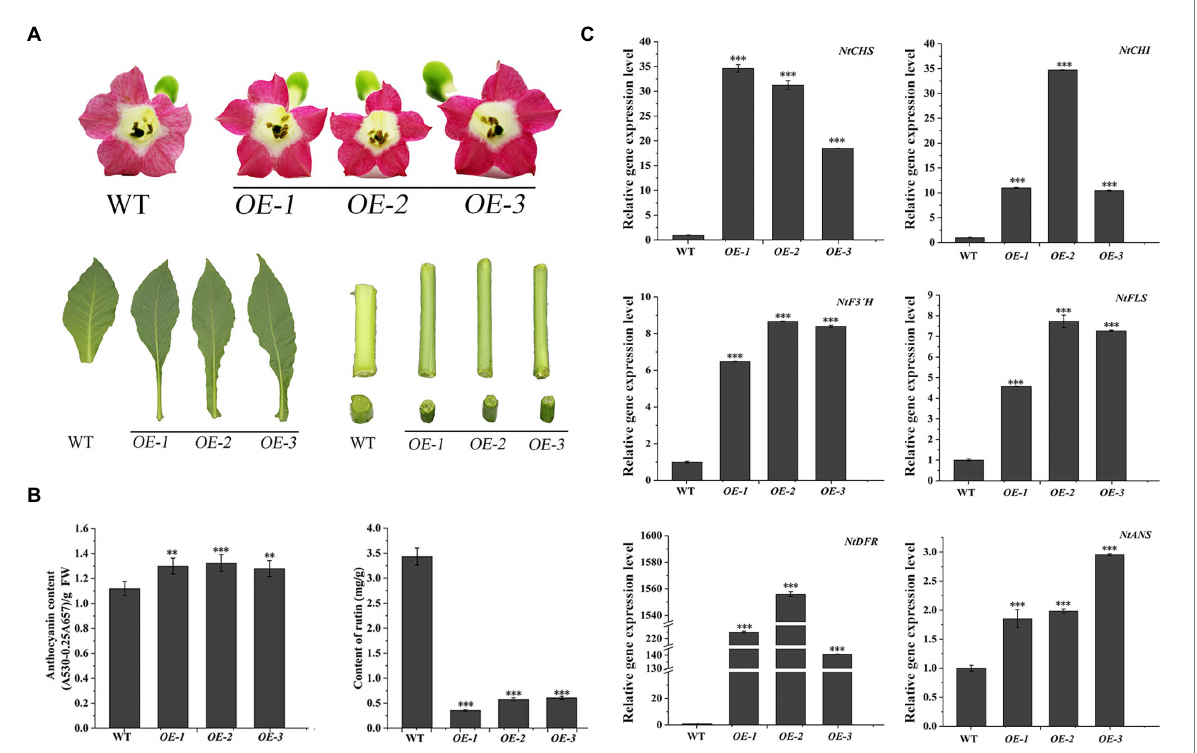
FIGURE 6 Overexpression of FtF3 ′ H1 gene promotes the accumulation of anthocyanins and inhibits the accumulation of rutin in N. tabacum . (A) Flowers petal pigmentation, leaf and stem growth in transgenic N. tabacum lines OE-1, OE-2 and OE-3. WT is the control. (B) Anthocyanins and rutin contents in transgenic N. tabacum . The average value is calculated repeatedly by three times of technology, and error bars indicate ± SD. ** p < 0.01 and *** p < 0.001. (C) Detection of transcriptional levels of flavonoid biosynthetic genes in transgenic N. tabacum . Nt β -actin gene are used as a reference in N. tabacum . The average value is calculated repeatedly by three times of technology, and error bars indicate ± SD. * p < 0.05, ** p < 0.01 and *** p <